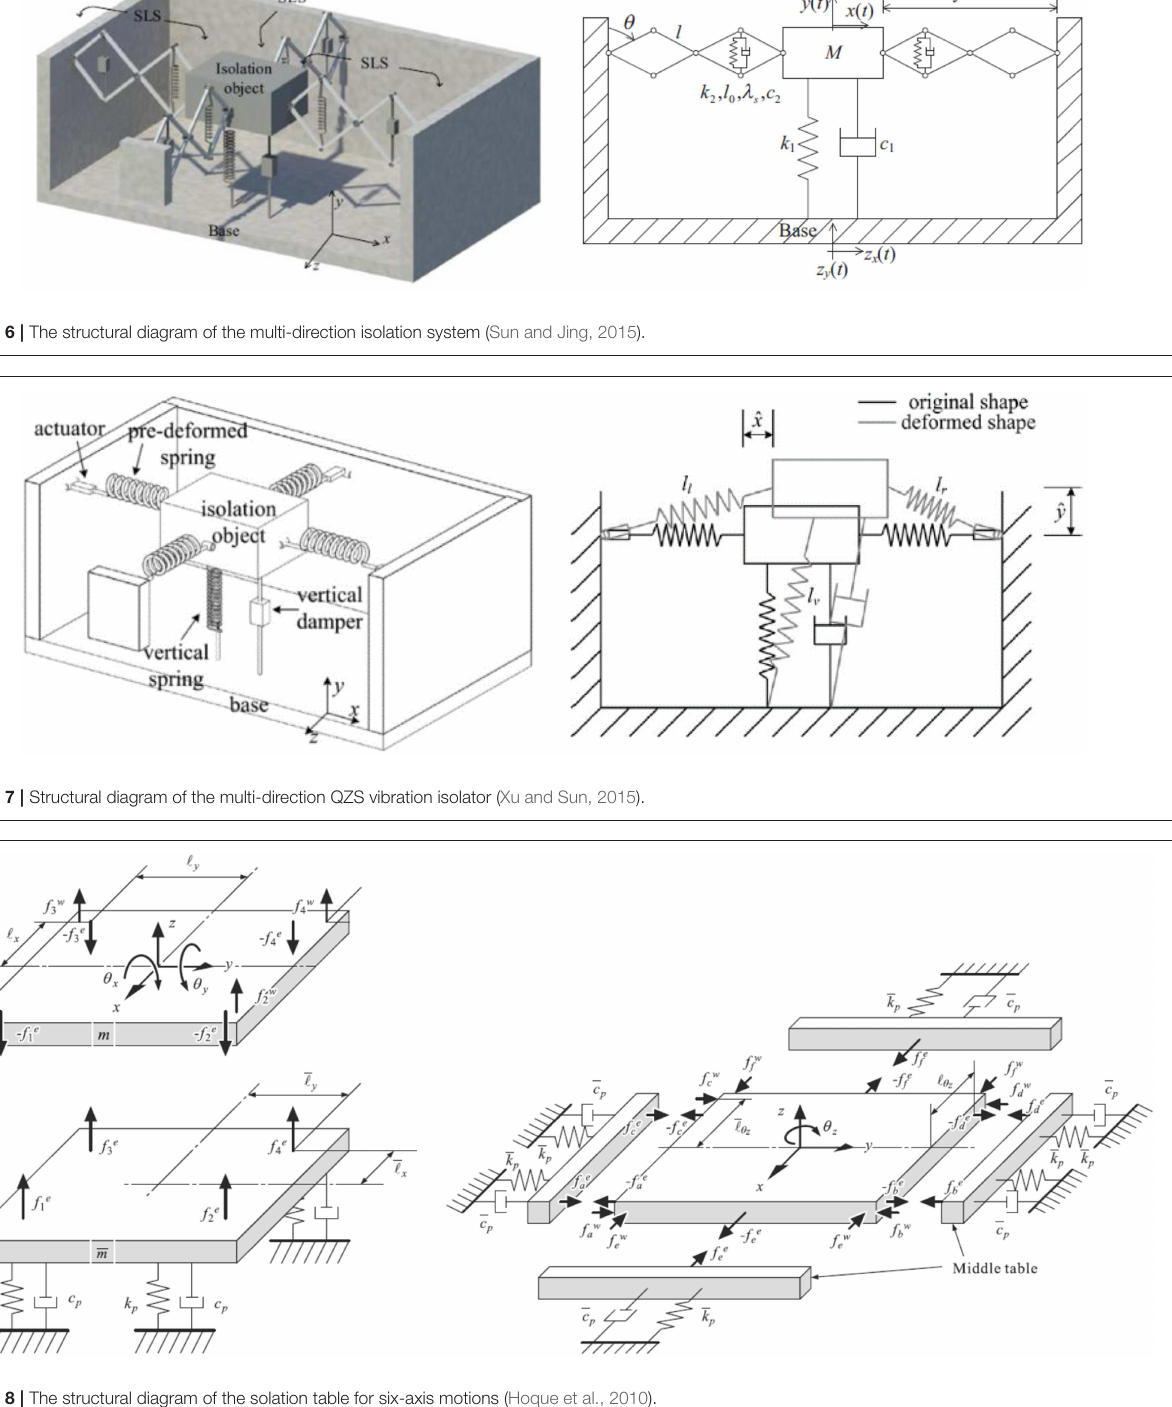
the translations and rotations of the manipulator.